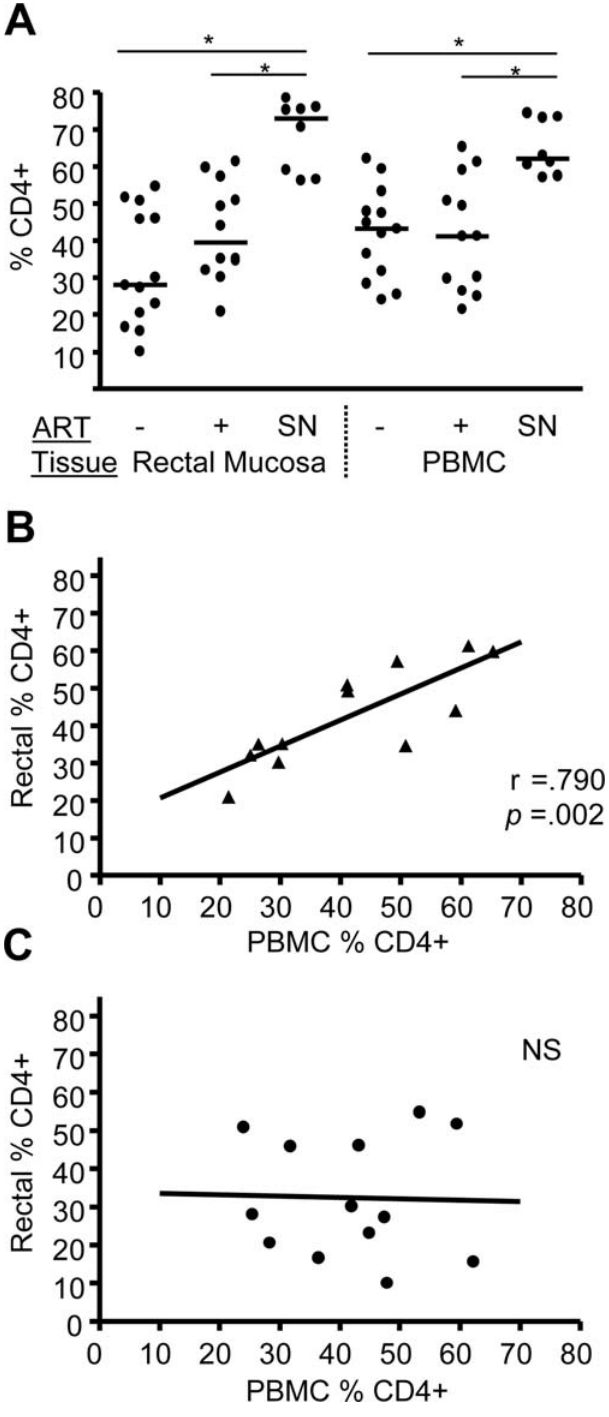
Figure 2. CD4 + T-cell percentages in rectal mucosa and peripheral blood. (A) CD4 values for rectal mucosa and peripheral blood are indicated as a percentage of CD3 + cells for subjects on and off ART, and seronegative subjects. The horizontal line denotes the median. Statistically significant differences (p , 0.05) within each tissue are denoted by a line with asterisk. SN, seronegative. (B & C) Correlation analysis (Spearman) of CD4 + T-cell percentages from each tissue for patients on ART (Part B, filled triangles) and not on ART (Part C, filled circles). Lines represent best fits as estimated by linear regression.